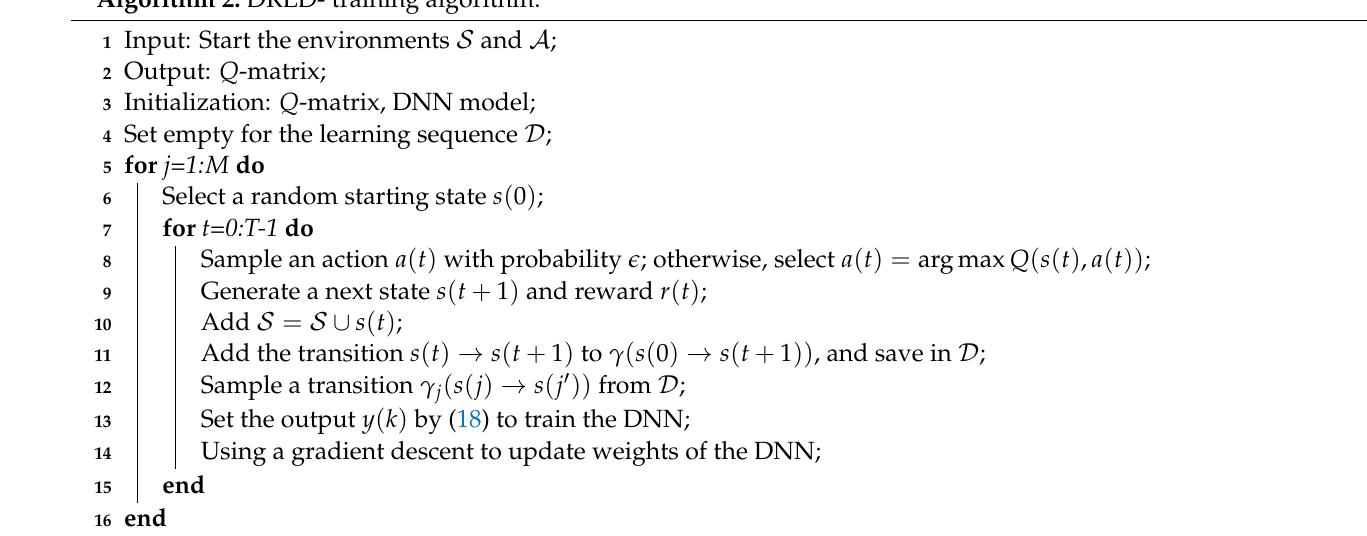
Algorithm 2: DRLD- training